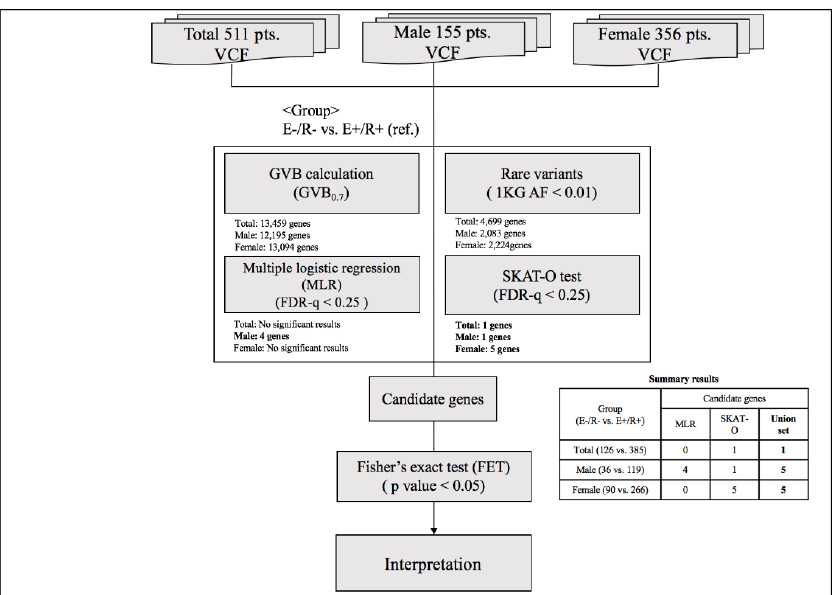
Figure 2. Summary of the analytic process. Abbreviations: VCF, Variant Call Format; GVB, gene-wise variant burden; 1 KG AF, Allele frequency of 1000 Genome; E( − ) / R( − ), later non-remission group in patients exhibiting poor early improvement; E( + ) / R( + ), later remission group in patients exhibiting early improvement, FDR, False discovery